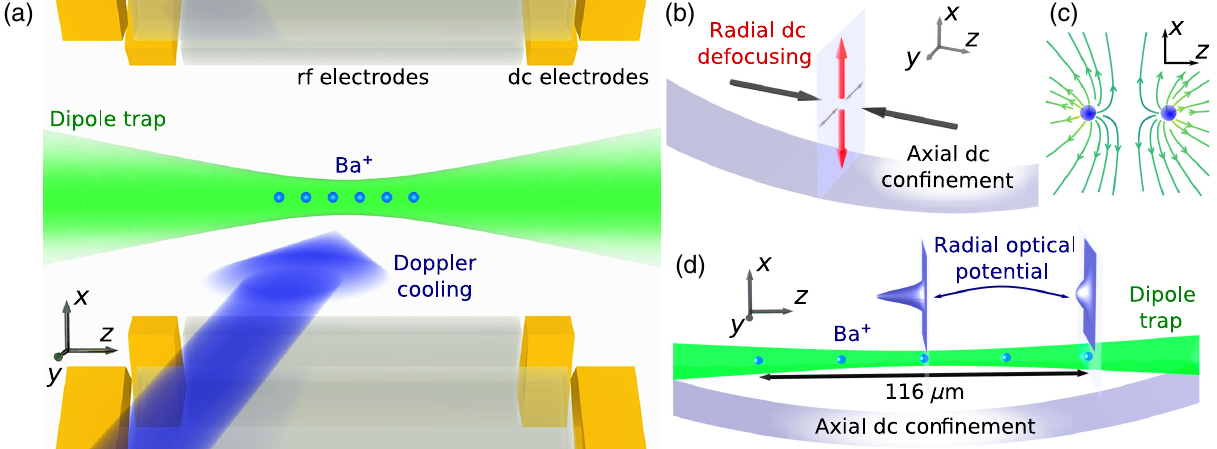
FIG. 1. Schematic of the apparatus and contributions to the total trapping potential. (a) We load chains of up to six Doppler-cooled barium ions, with lengths of up to 135 μ m (the 5-ion crystal in (d) has a length of 115 μ m), into a linear rf trap. dc electrodes are used to adjust the external electrostatic potential. The ions are then transferred from the rf trap into either a visible (VIS) or near-infrared (NIR) optical dipole trap by ramping up the optical potential and simultaneously turning off the rf fields. Axial dc confinement in the external electrostatic potential [grey surfaces in (b) and (d)], as well as the ions ’ mutual Coulomb interaction (c), lead to additional defocusing forces in the radial directions. In our experiment, defocusing is chosen to predominantly lie in the x direction [red arrows in (b)] while defocusing in the y direction is negligible (thin gray arrows). With Rayleigh lengths z VIS R ¼ 40 μ m and z NIR R ¼ 74 μ m for the respective dipole laser beams, the radial optical potential depicted by the blue surfaces in (d) also depends on the ion position along the z